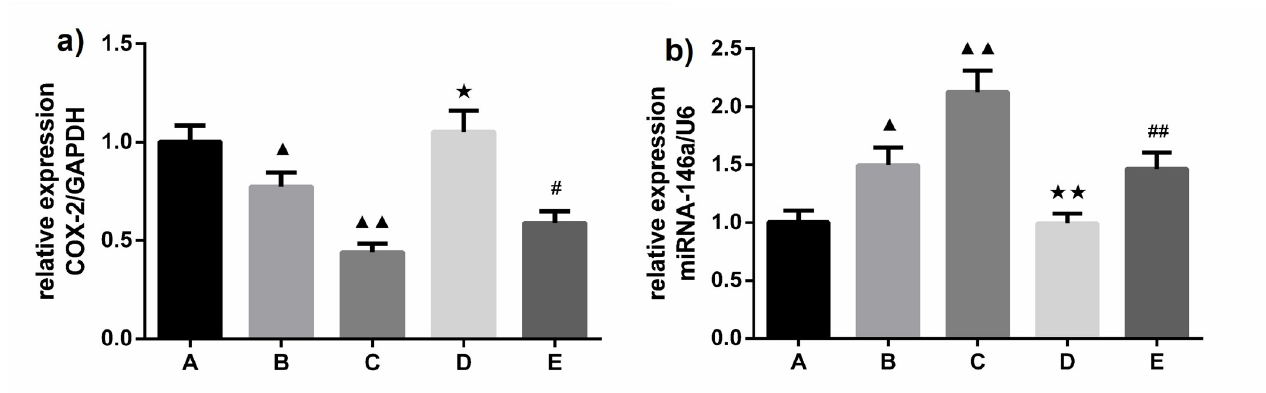
Fig 5. Effects of varying papain concentrations on MPA-mediated expression of COX-2 mRNA and miRNA-146a. ( � x ± s , n = 3). RT-PCR was used to detect expression of a) COX-2 mRNA and b) miRNA-146a in a co-culture system of THP-1 cells and activated platelets following 100 or 200 U/L of papain treatment. A: negative control; B: 100 U/L papain; C: 200 U/L papain; D: 100 U/L papain combined miRNA-146a inhibitor; E: 200 U/L papain combined miRNA-146a inhibitors. ▲ , ✭ , # P < 0.05 and ▲▲ , ✭✭ , ## P < 0.01 compared with negative control, 100 U/L papain, and 200 U/L papain groups, respectively, as analyzed by LSD- t